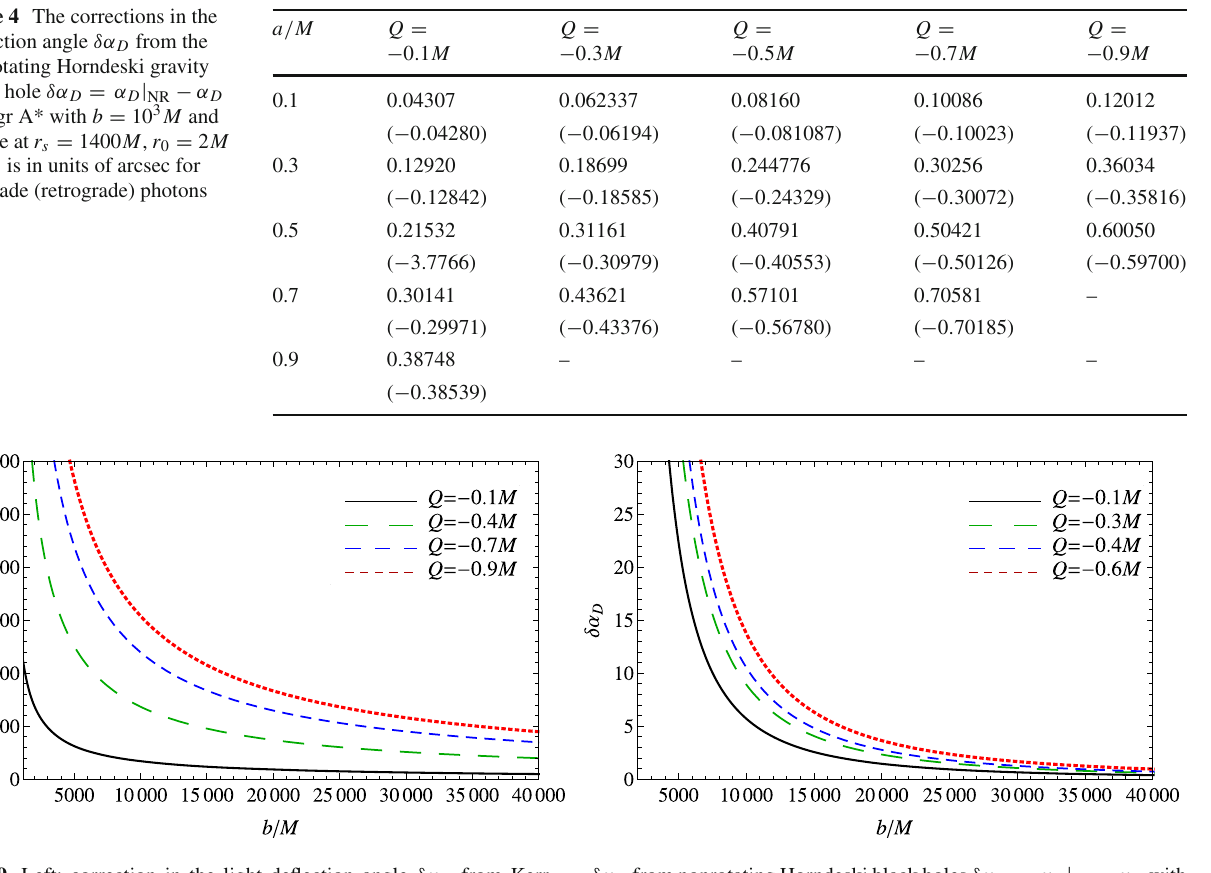
Fig. 9 Left: correction in the light deflection angle δα D from Kerr black holes δα D = α D − α D | Kerr with a = 0 . 50 M , and varying b ; δα D is in units of arcsec. Right: correction in the light deflection angle